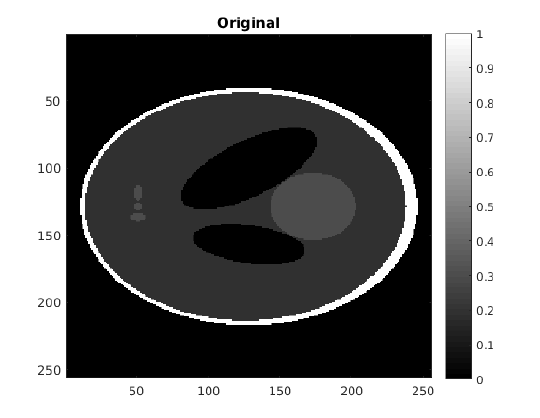
Figure 2. Original